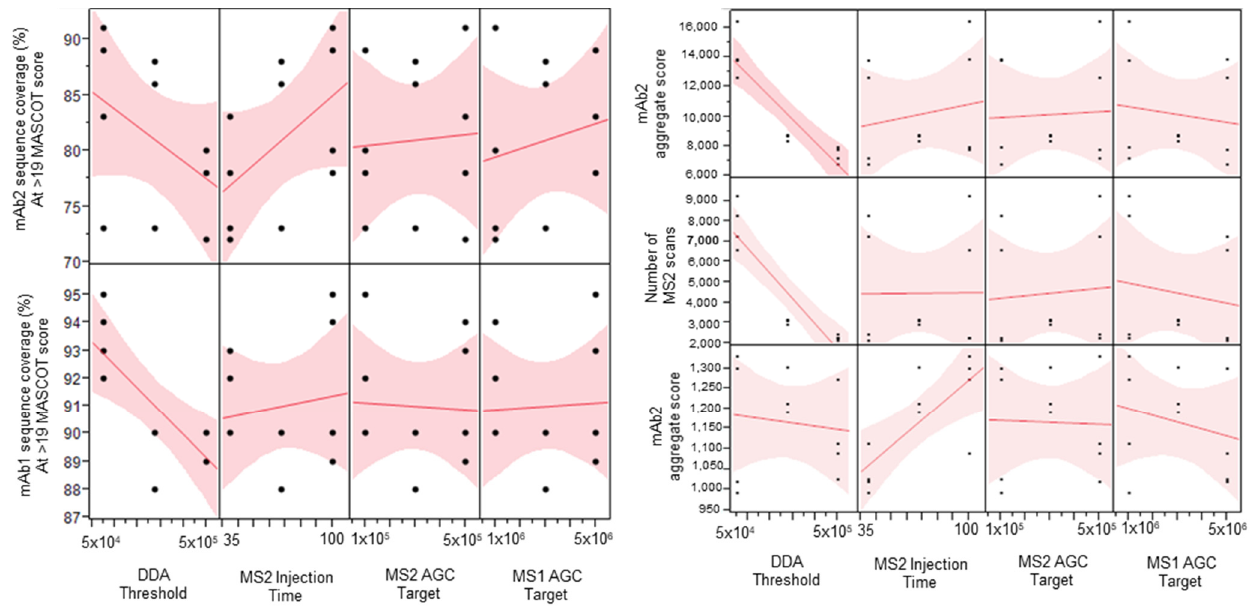
Figure 1. Scatterplot matrix showing the main effects of each factor on sequence coverage, aggregate score, and number of MS/MS scans.